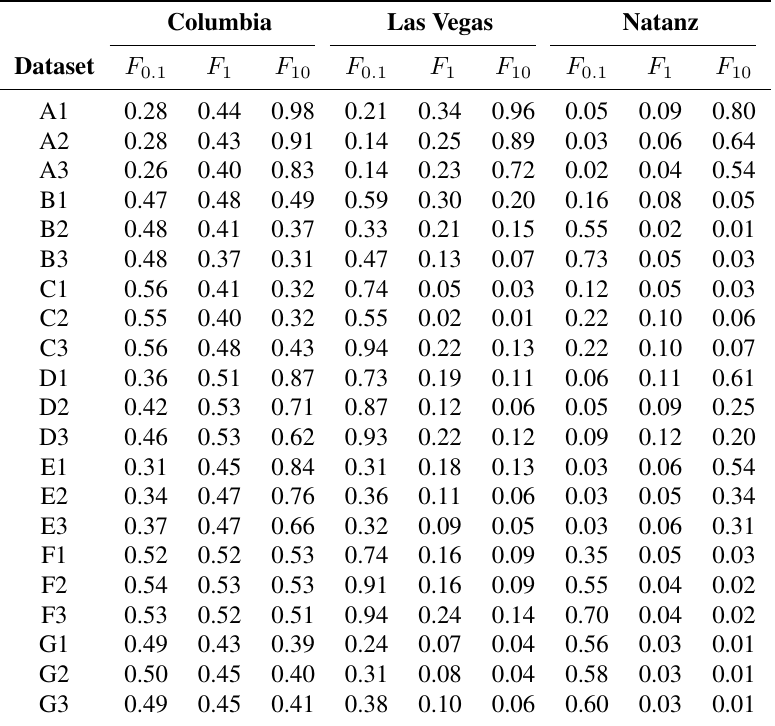
Table 15. Analysis of random forest change prediction results using a generalized